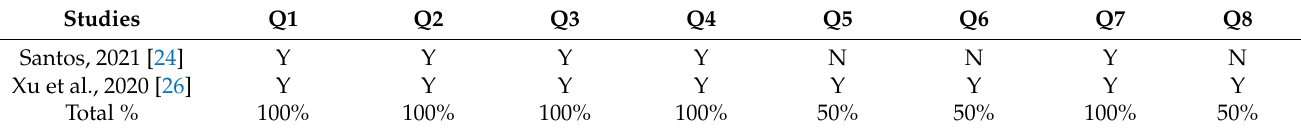
Table 4. Critical evaluation of the cross-sectional studies included, S ã o Paulo, SP, Brazil,